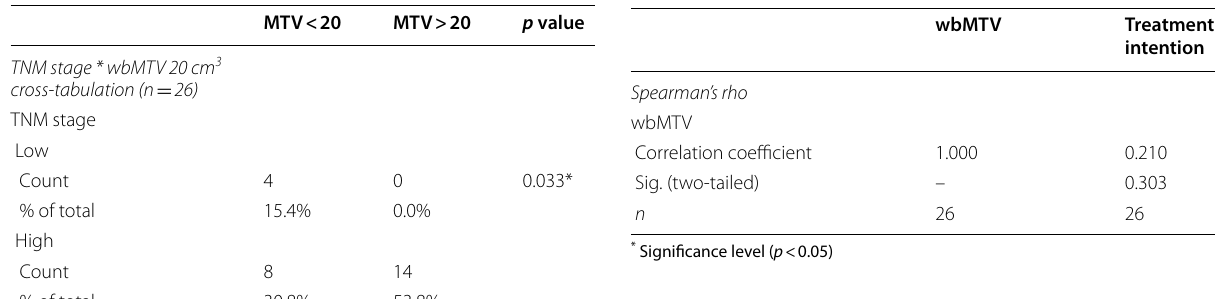
Table.6 Outcome according to wbMTV 20 cm 3 with TNM stage Table.7 Correlation between wbMTV and treatment